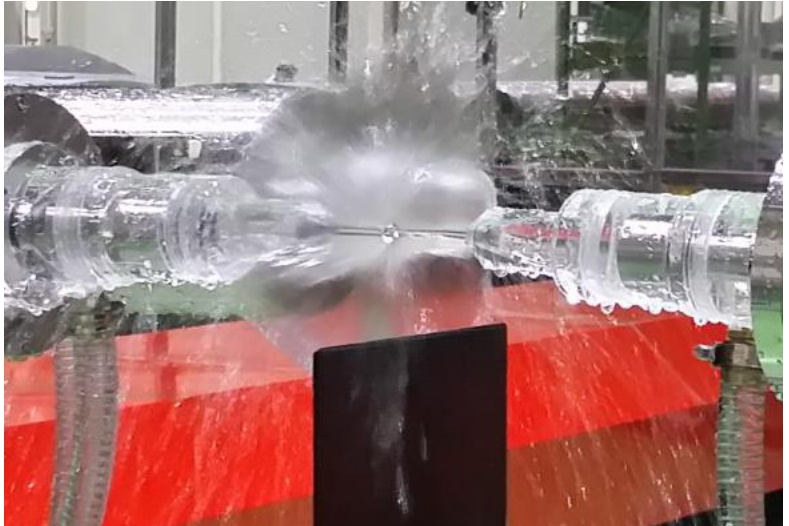
Figure 6. Shape of the squirter.